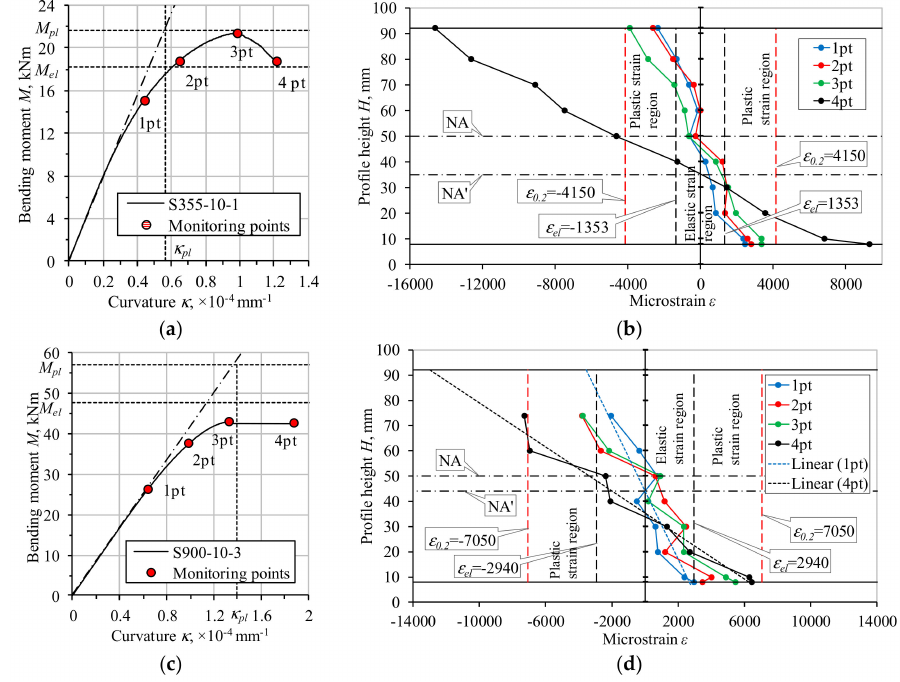
Figure 6. Moment-curvature diagrams: ( a ) NSS, ( b ) HSS; and strain distribution: ( c ) NSS, ( d )